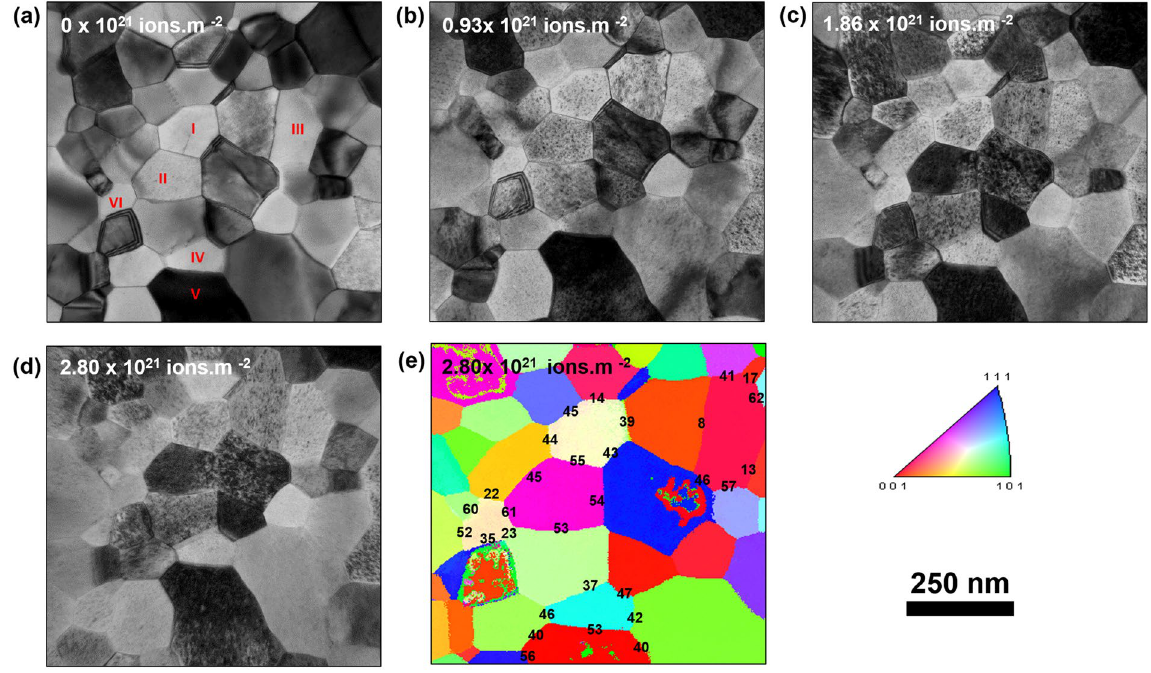
Figure 1. ( a ) Bright-field TEM image of free-standing nanocrystalline Fe film before irradiation. Labelled grains are used in the quantification part of loop density and size as a function of irradiation dose ( b ), ( c ) and ( d ): Bright-field TEM images of the irradiated Fe film with 10 keV He at 573 K to 0.93, 1.86 and 2.87 × 10 21 ion.m − 2 respectively. ( e ) ACOM map of ( d